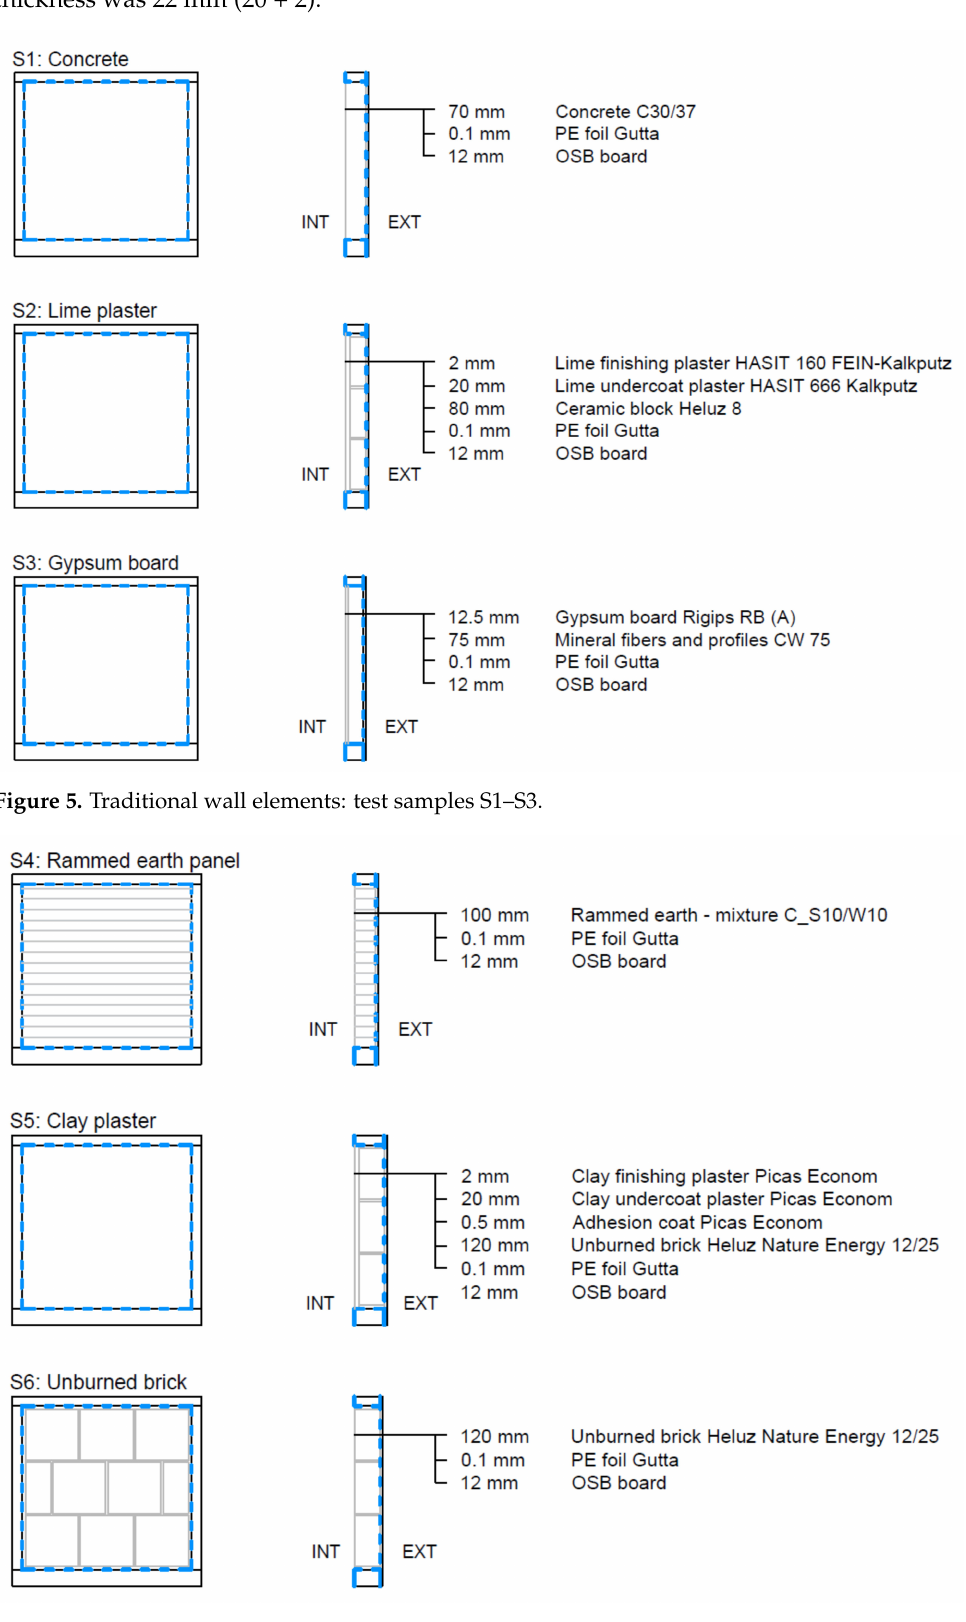
Figure 6. Clay-based wall elements: test samples